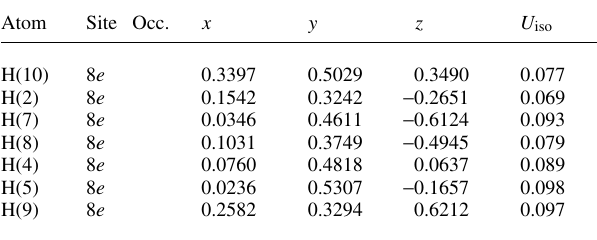
Table 2. Atomic coordinates and displacement parameters (in Å 2 )